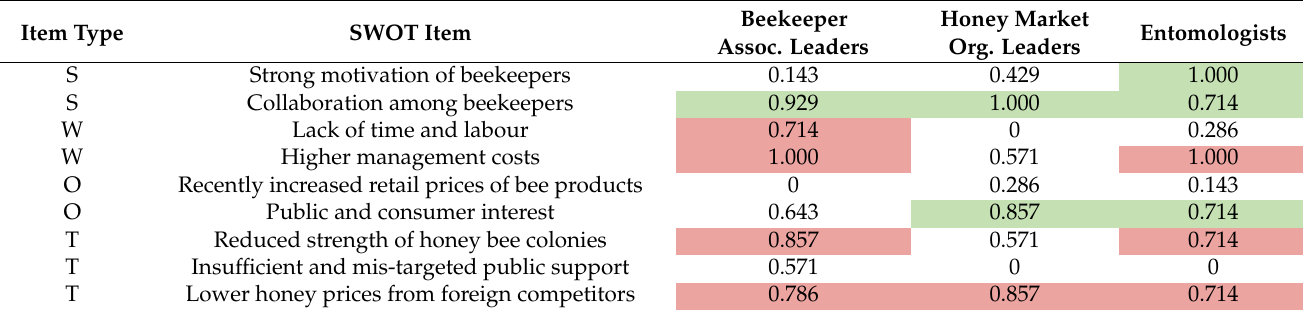
Table 2. Ranking of the mutual effects—algebraic sums of the scores per row (normalised values).